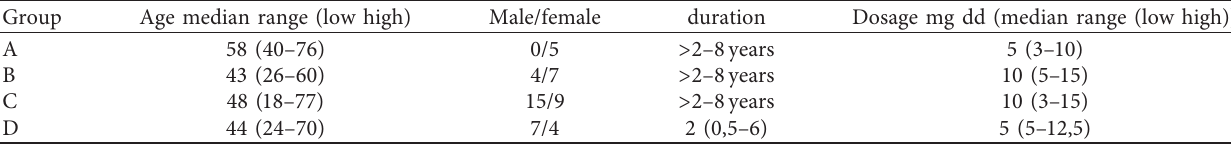
Table 2: Summary of patients group characteristics including the baselines age, sex, duration of treatment, and the dosage.